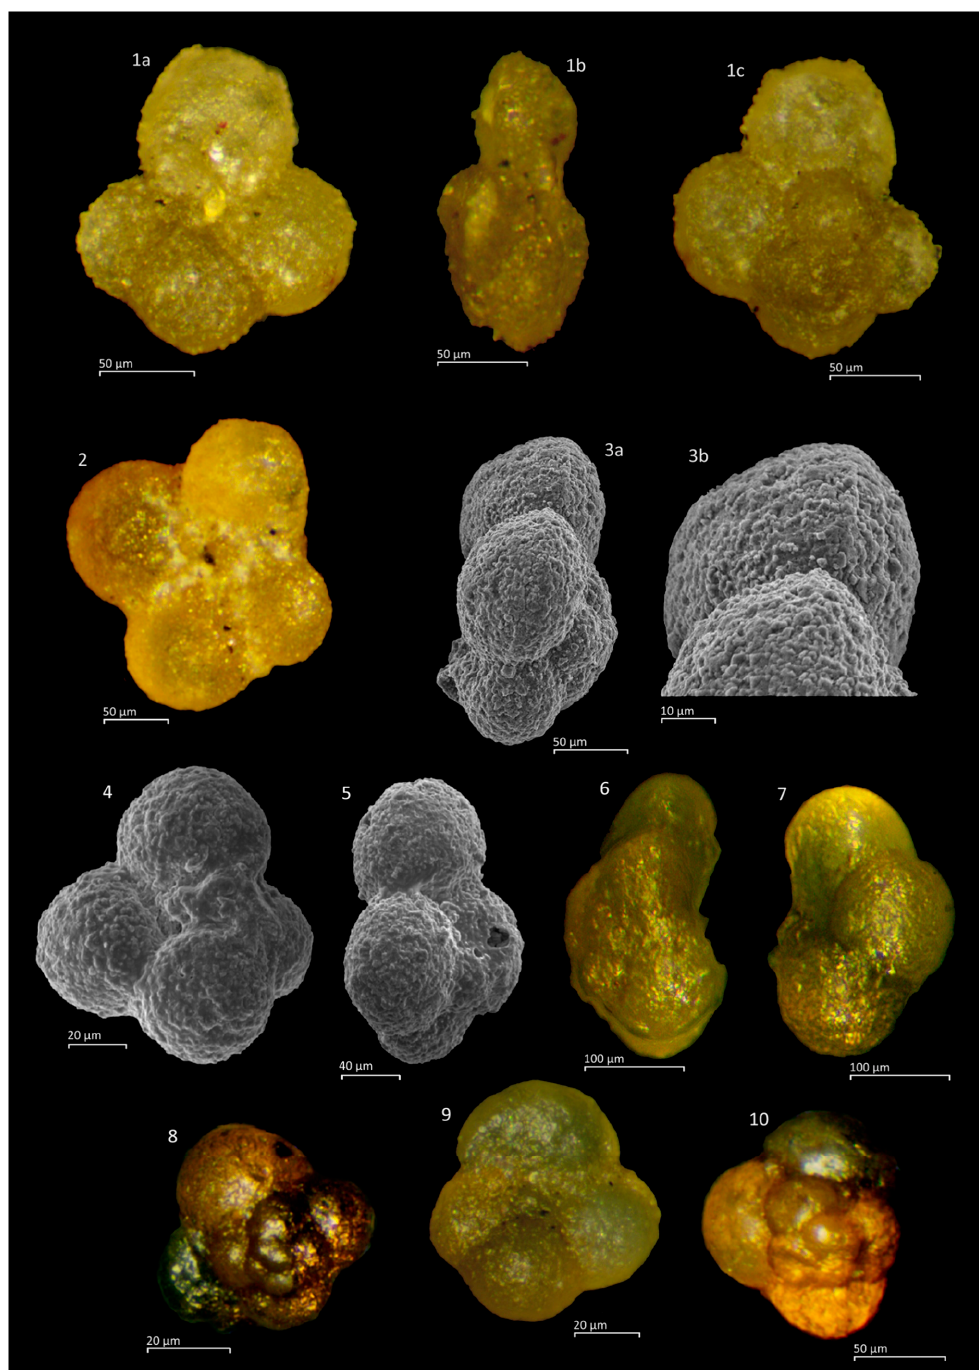
Figure A5. Petaloglobigerina simmonsi Gradstein. Subfigures 1 and 2 , holotype and paratype specimens, sample 10, Section 1, Tojeira Formation, lower Kimmeridgian, Montejunto, Portugal. Subfigure 3a, b , paratype specimen, samples 6–28, upper Tojeira Fm., lower Kimmeridgian, Montejunto, Portugal; note the four chambered last whorl with pointed periphery and the densely pustulose wall texture. Globuligerina balakhmatovae (Morozova). Subfigure 4 , cuttings sample 8360 (cid:48) , Eider well, Grand Banks, Bajocian-Bathonian; wall texture pustulose. Subfigure 5 , sample 24/2P, Tojeira Formation, Montejunto, Portugal, lower Kimmeridgian; wall texture coarsely pustulose. Subfigures 6 – 10 , side, umbilical and spiral views of topotypes of Globuligerina balakhmatovae (Morozova), sample 8, Parkinsonii Zone, Upper Bajocian, Khouroukra,